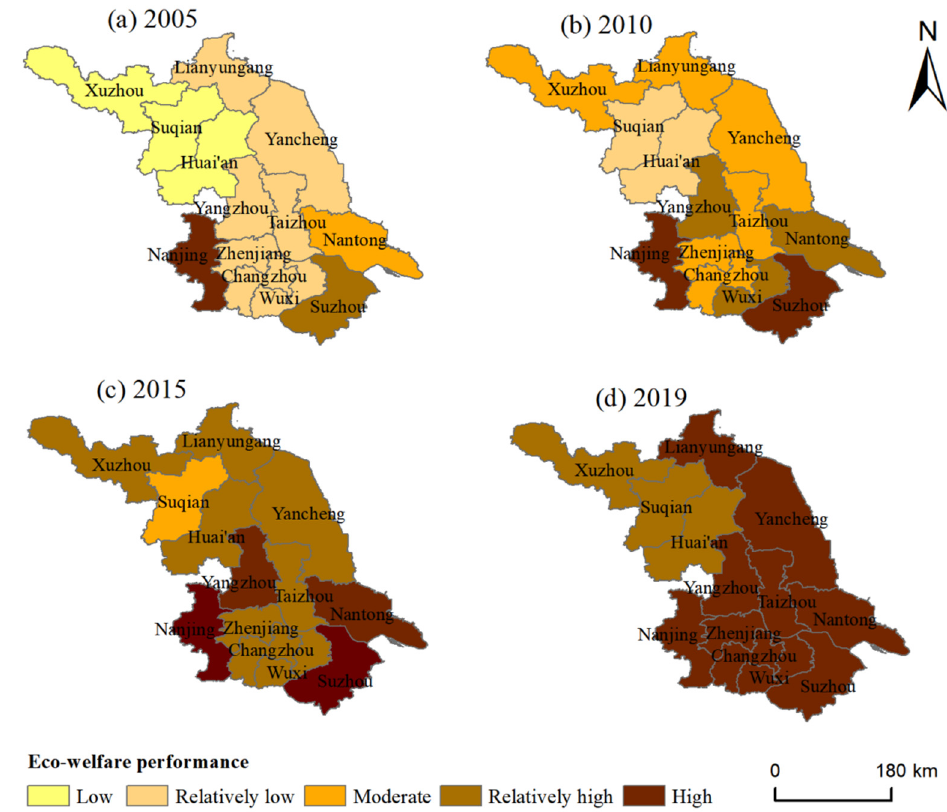
Figure 4. Spatial patterns of urban ecological welfare performance in Jiangsu province.